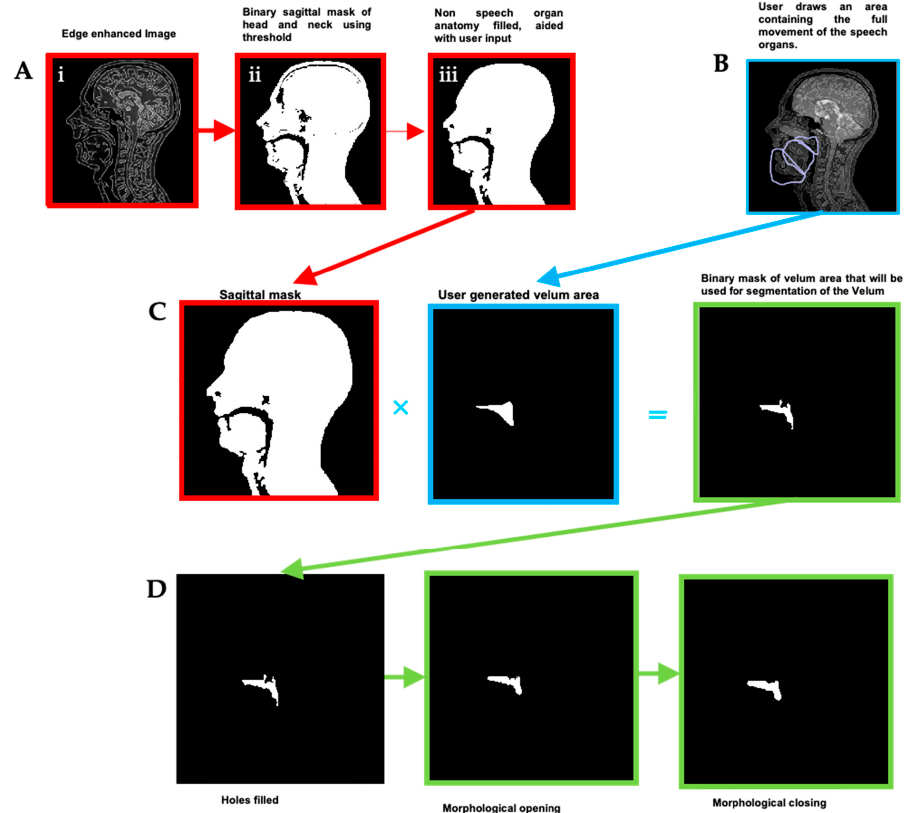
Figure 3. Creation and optimisation of the “head” and velum masks: ( A ) A binary mask of the head with the upper respiratory tract is made with some user input. ( B ) An area is drawn by the user that will enclose all potential positions the speech organ may move into through time. Overlap between masks of the di ff erent speech organs will be removed later through a combination of logical and morphological operators. ( C ) Initial segmentation: The binary mask of the user-generated velum area is multiplied on a pixel-by-pixel basis (Hadamard product) with the sagittal mask to create a binary image that is used to segment the velum. ( D ) Morphological operators are used to smooth the masks and fill